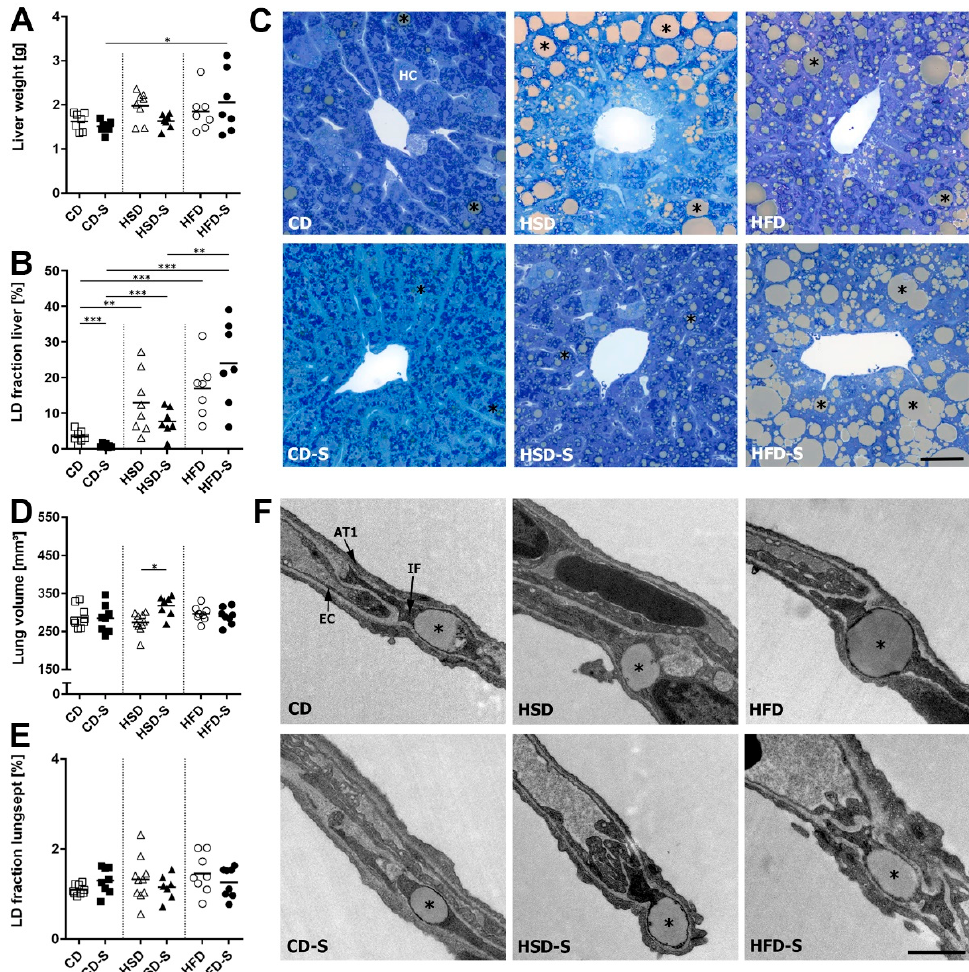
Figure 6. Effects of diets and spermidine on hepatic and pulmonary lipid accumulation. ( A ) Liver weight. ( B ) Percentage of area occupied by lipid droplets in the liver. ( C ) Representative light microscopy images of toluidine blue stained liver sections, scale bar = 50 µm. ( D ) Lung volume. ( E ) Percentage of area occupied by lipid droplets in alveolar septa. ( F ) Representative electron microscopy images of the pulmonary septal region, scale bar = 1 µm. ( A , B , D , E ) Data shown as values of individual mice, group means are indicated by horizontal lines; data were compared by 2W-ANOVA followed by Tukey test; * p < 0.05, ** p < 0.01, *** p < 0.001. CD, control diet; HSD, high sucrose diet; HFD, high fat diet; -S, spermidine; *, LD; HC, hepatocyte; IF, interstitial fibroblast; AT1, epithelial type 1 cell; EC, endothelial cell.